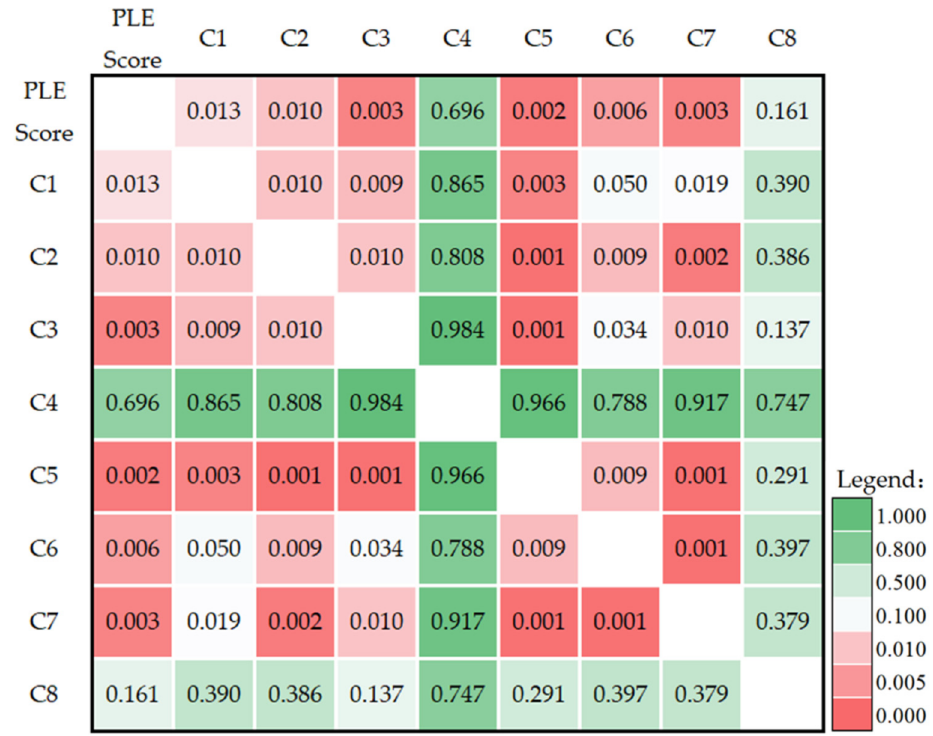
Figure 11. The significance of Pearson results between the PLE scores and the C-layer